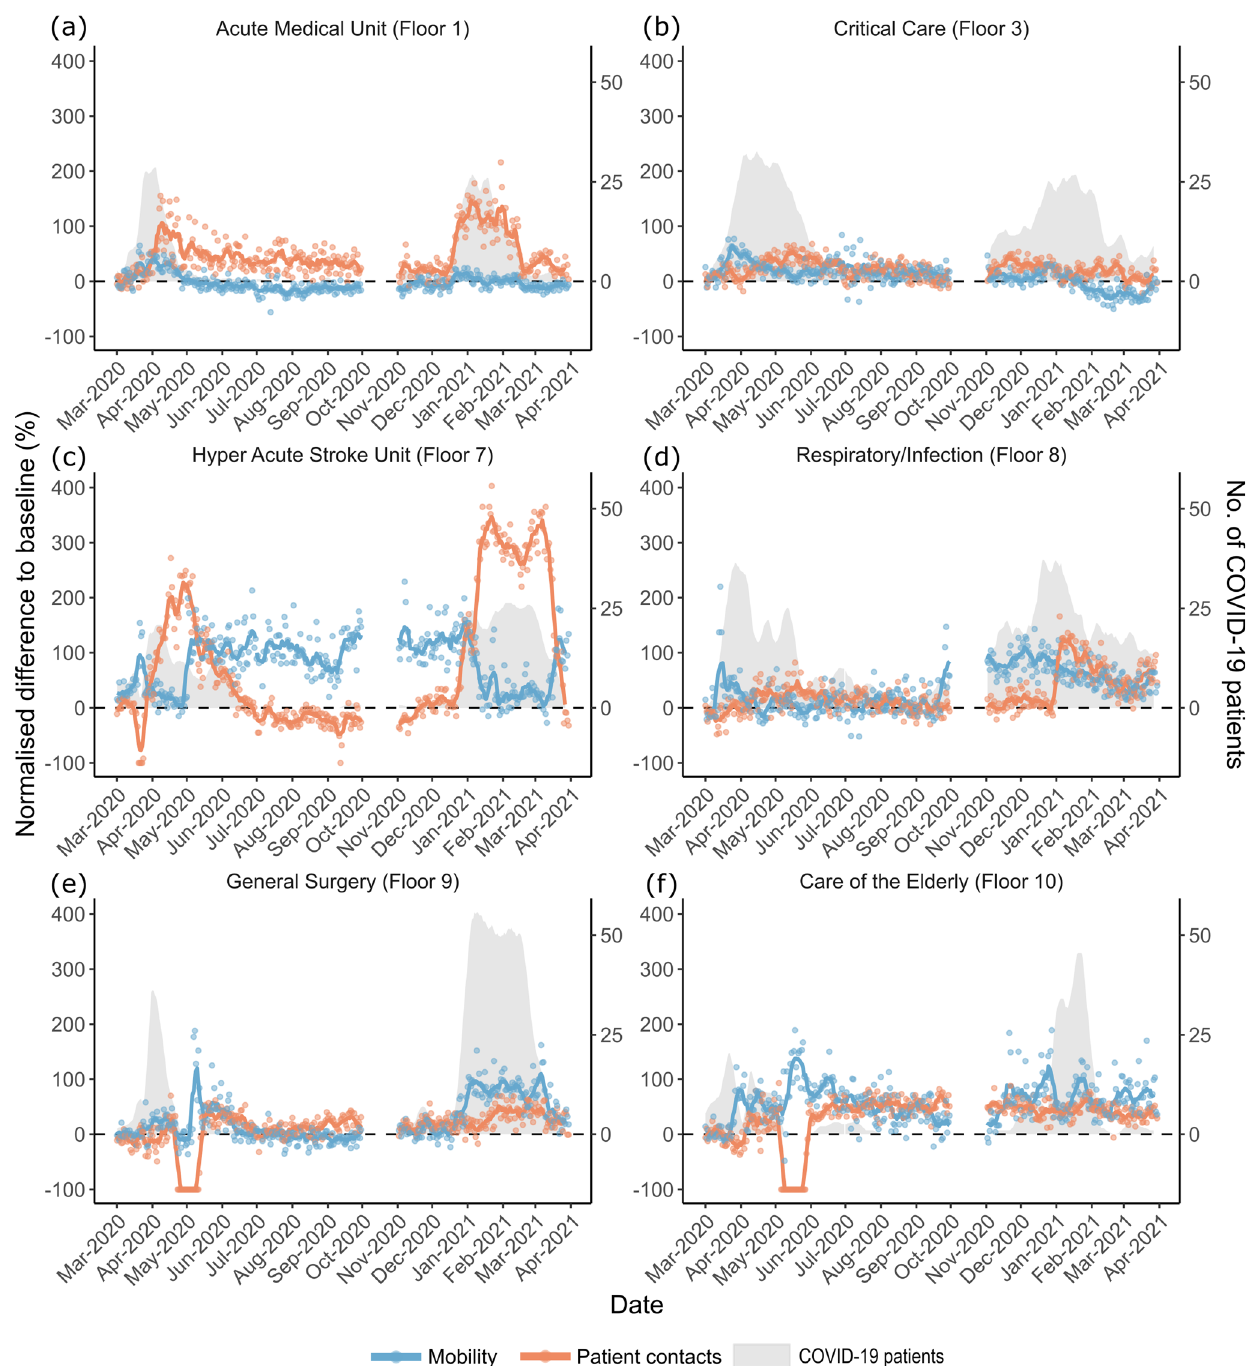
Fig. 3 Changes in the daily rate of healthcare worker mobility and patient contacts on COVID-19 fl oors in the Tower building at University College London Hospital during the fi rst year of the COVID-19 pandemic. The normalized difference to baseline for daily rates of healthcare worker mobility ( N Mr t ; blue points) and patient contacts ( N Cr t ; red points) are plotted for COVID-19 fl oors: a Acute medical unit. b Critical care. c Hyper acute stroke unit. d Respiratory/infection ward. e General surgery. f Care of the elderly. The solid blue and red lines represent the seven day rolling averages. The horizontal black dotted dashed line represents 0% change compared to the average in the 2 months pre-pandemic. COVID-19 wards were identi fi ed as those that handled the majority (> = 15%) of all COVID-19 patients in the hospital during the observation period. The grey polygons indicate the number of COVID-19 patients on the fl oor. Data for October 2020 was not ^ β = p = 0.249) or during the second wave ( 0.20%; CI = 0.00%, 0.41%; t 355 = 1.922; p = 0.055).